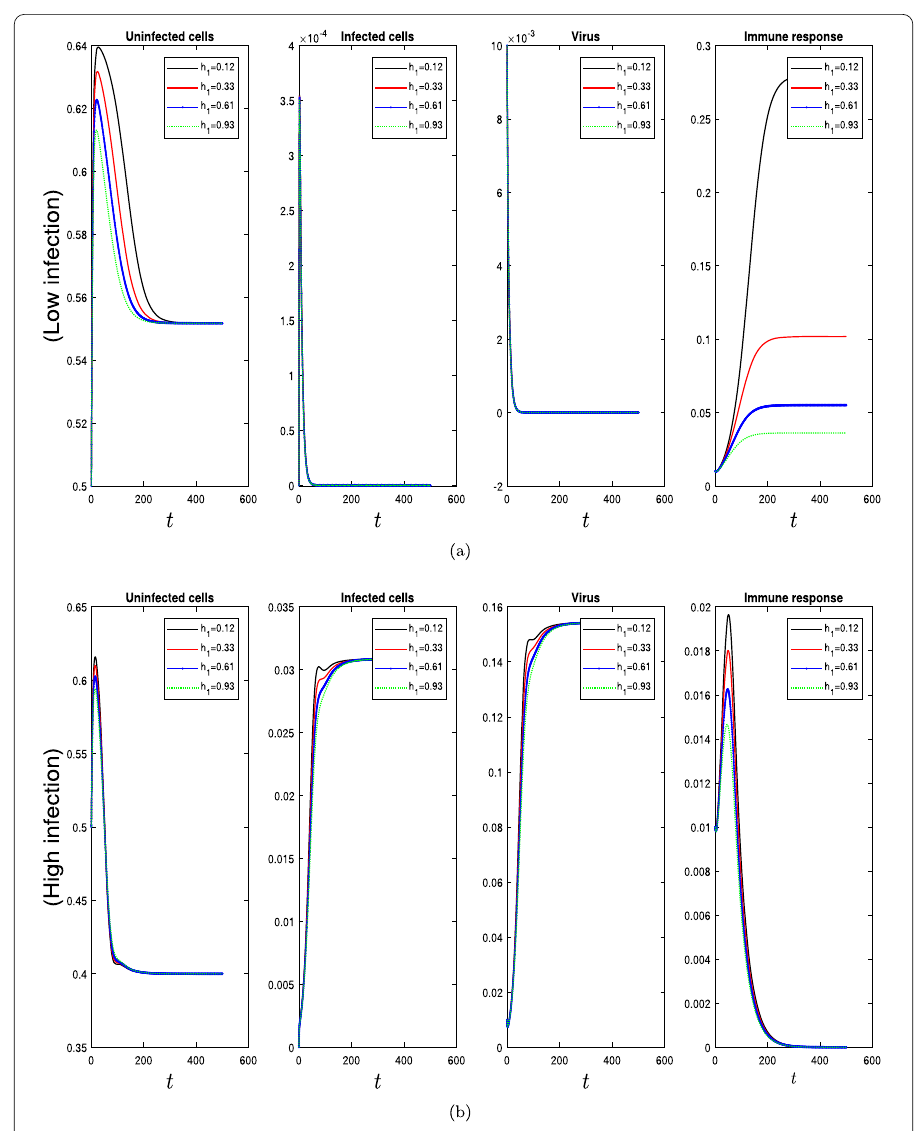
Figure 8 Numerical simulations of model (2) with initial values: x (0) = 0.5, y (0) = 0, v (0) = 0.01, and z (0) = 0.01, showing the time variation in each compartment of the model with varying values of h 1 as shown in the legend (other parameters are set as in (11) except n = 0.16). The simulations are carried out for two cases of infection rate, ( a ) low infection ( a = 0.1) and ( b ) high infection ( a = 0.5)